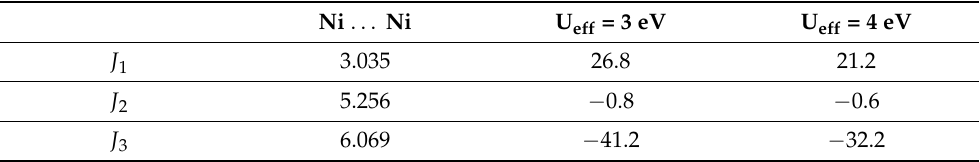
Table 6. Experimental Ni . . . Ni distances (in Å) and calculated spin exchanges (in K), obtained from DFT + U computations, of K 2 Ni 2 TeO 6 .